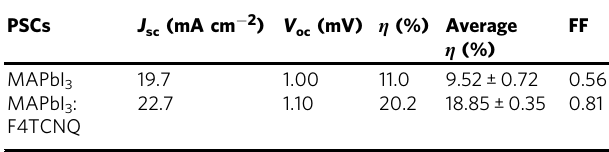
Data for average PCE ( η ) were calculated from at least 30